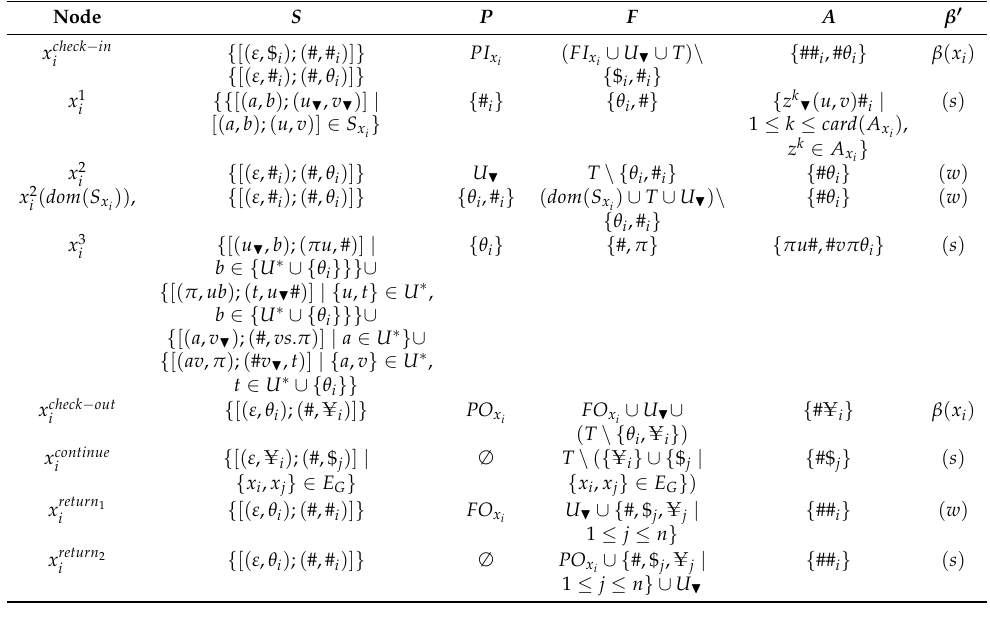
Table 2. Description of the intermediate nodes.